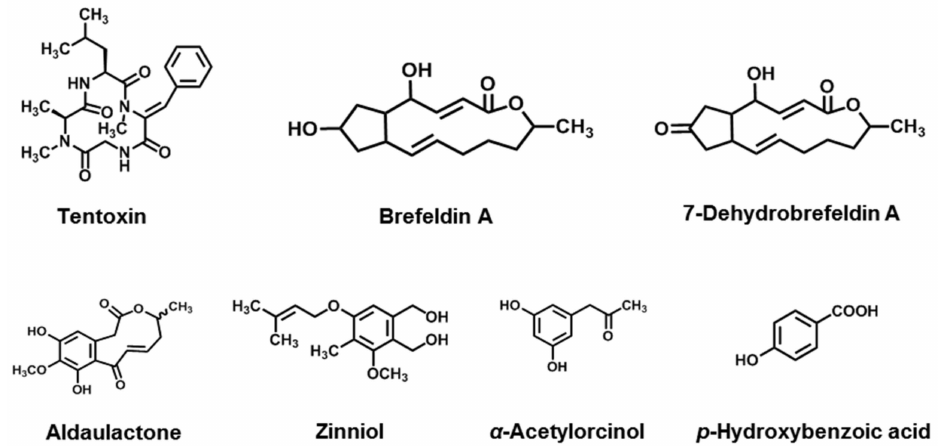
Figure 10. Chemical structures of Alternaria NHSTs belonging to the cyclic peptide (Tentoxin) macrolides (Brefeldin A, 7-dehydrobrefeldin A, and aldaulactone) and phenolics (Zinniol, a - acetylorcinol, and p -hydroxybenzoic acid)